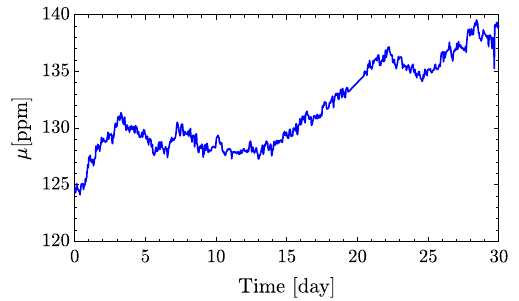
Fig. 9 Modified Allan deviation of the measured angular velocity Ω